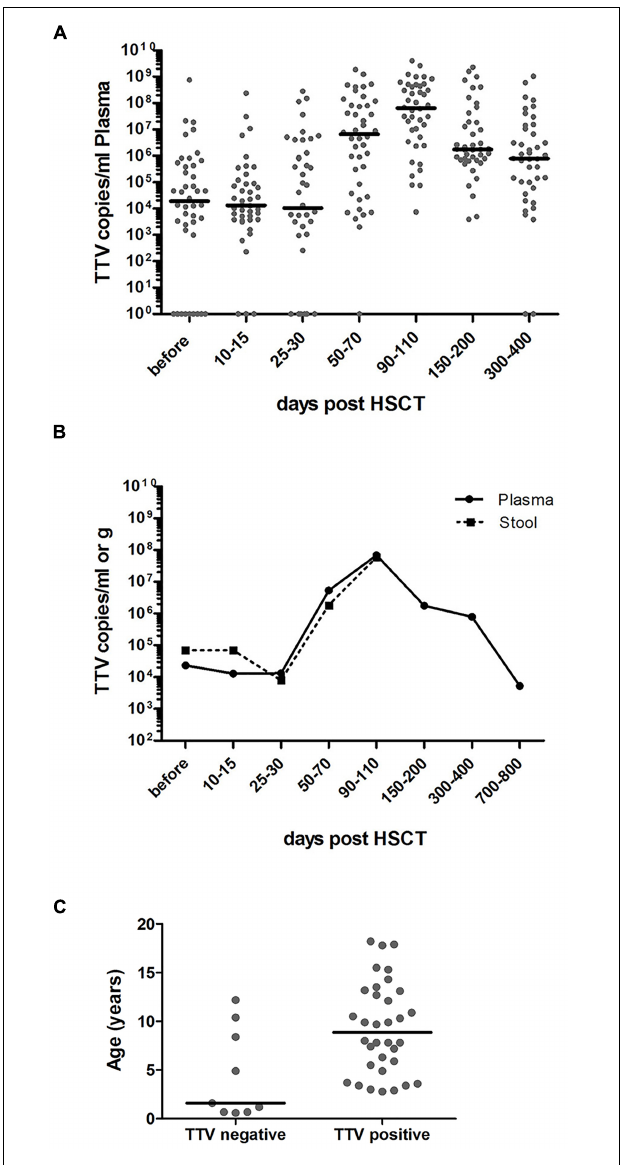
FIGURE 1 | RQ-PCR monitoring of TTV copies in plasma and stool before and after HSCT. RQ-PCR analysis detecting TTV was exploited to analyze the virus load. (A) The dot plot depicts the numbers of TTV copies/ml plasma in individual pediatric patients ( n = 43) during the indicated time periods before and after HSCT. The horizontal bars represent the respective median values. (B) The curves reflect the median values of TTV copies per ml plasma ( n = 43; solid line) or per gram stool ( n = 21; dashed line) during the indicated observation period. (C) The age of patients at the time of transplantation is shown in correlation with TTV negativity and positivity in plasma pre-transplant ( t -test; p <